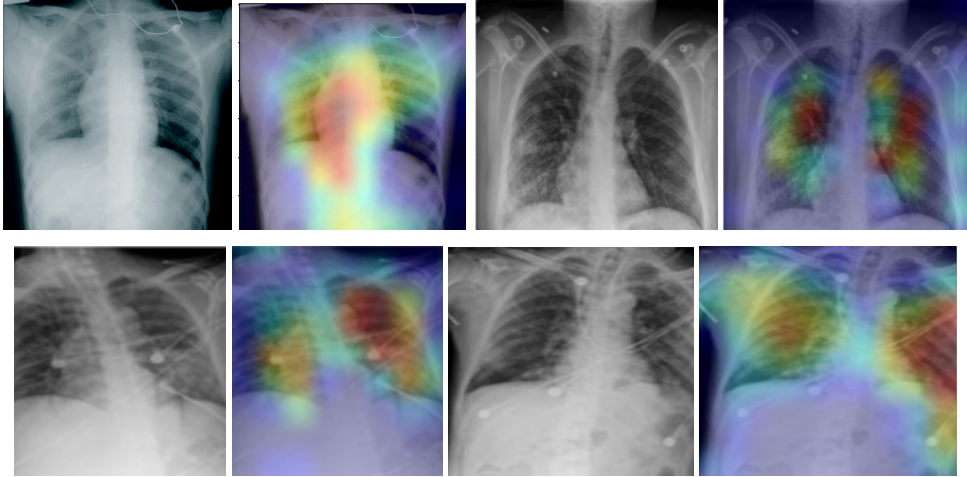
Figure 4. Aggregated confusion matrices for Approach 1 (end-to-end training)